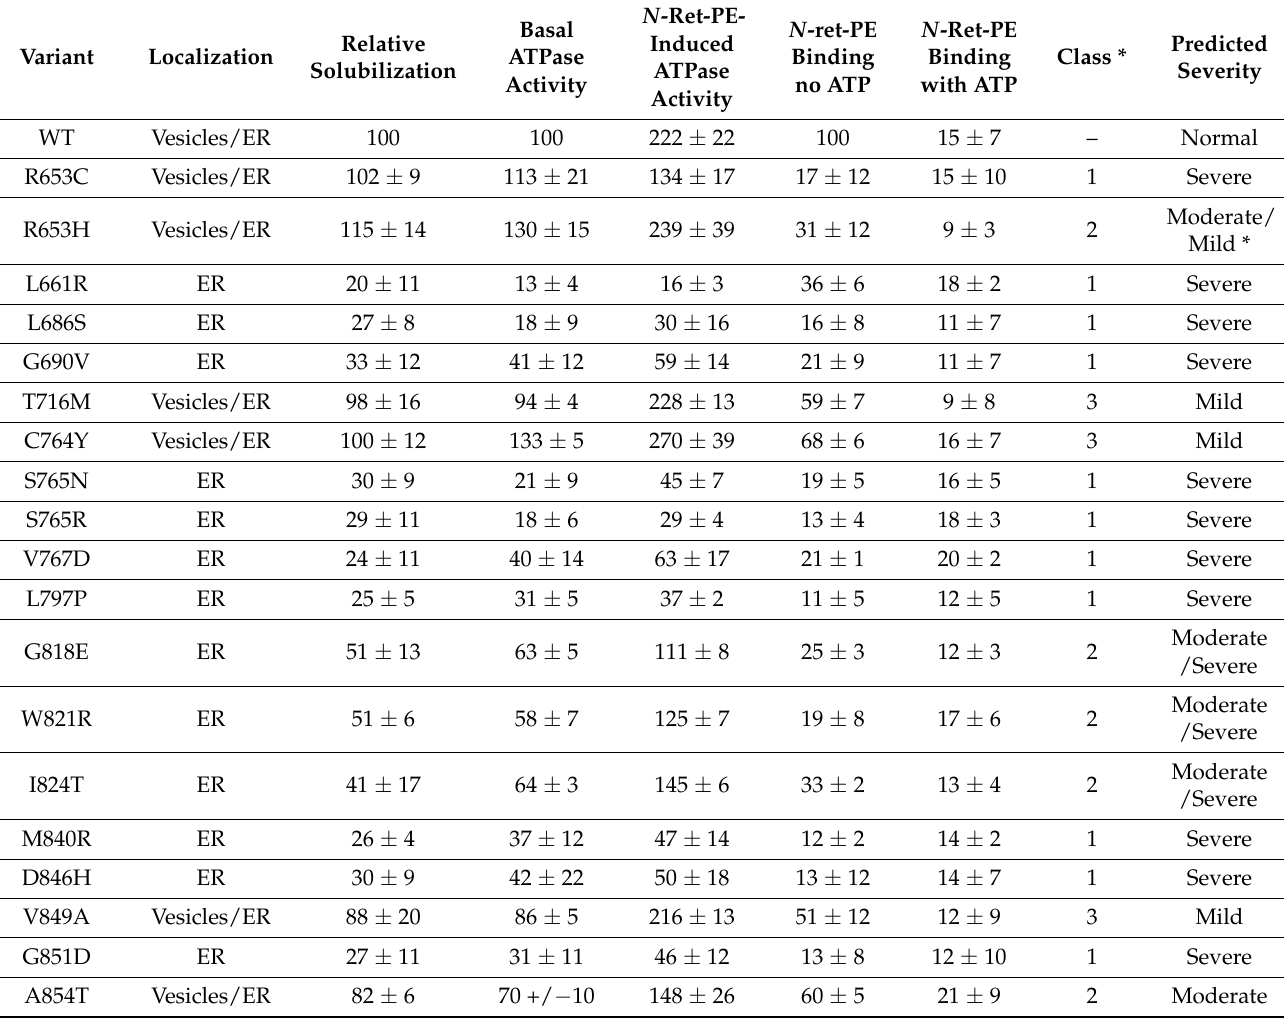
Table 1. Summary of biochemical analysis of TMD1 variants.